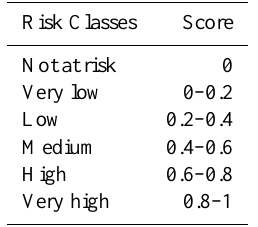
Table 8. Risk classes score definition used to characterize the total risk index (GIS equal interval